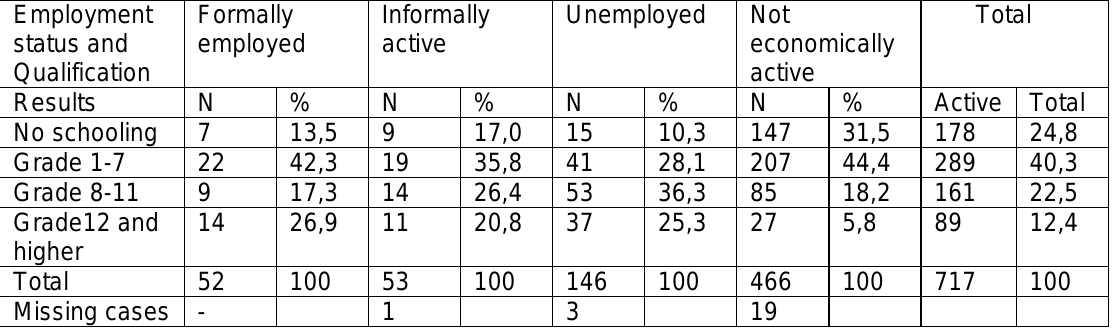
Table 2: Cross-tabulation of employment status and qualifications of the population in 2007